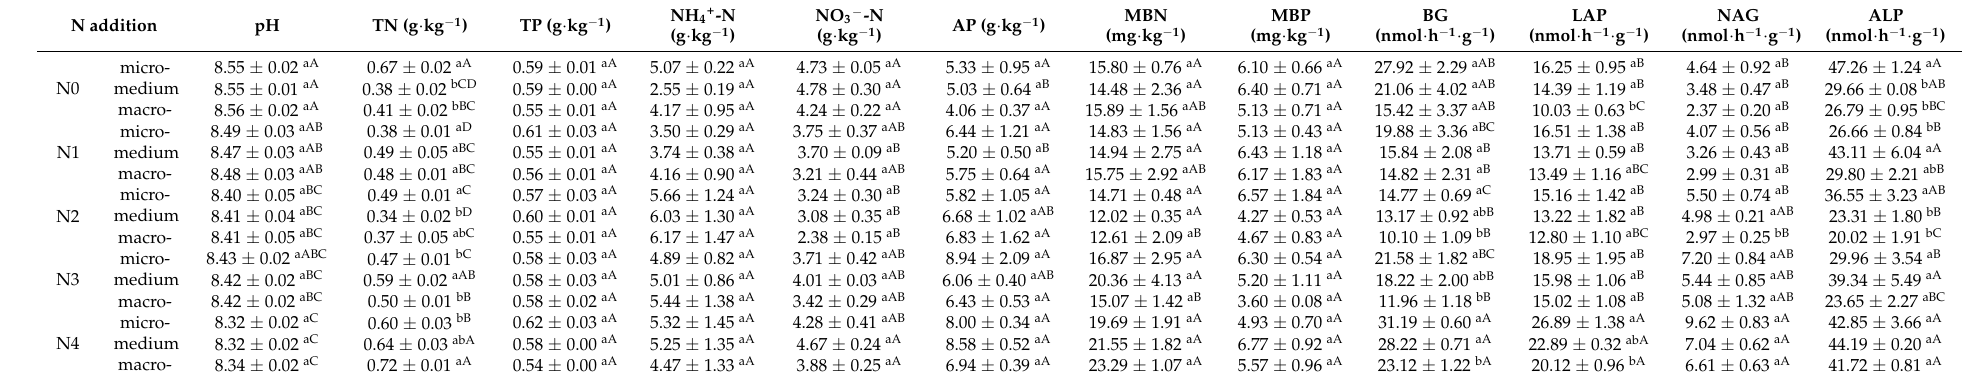
Table 2. Changes in soil physical and chemical properties of different soil aggregates under nitrogen